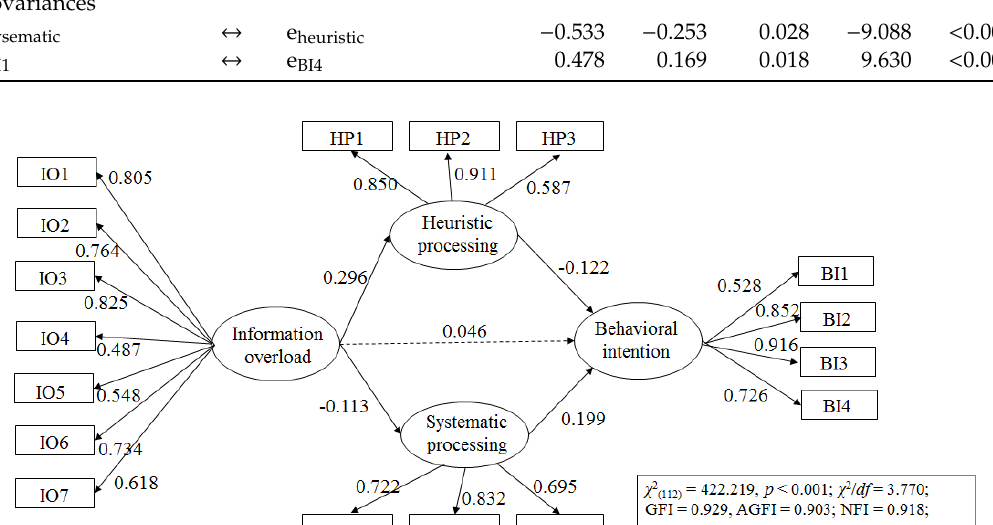
Figure 2. Results of structural equation modeling. Note. IO = information overload; HP = heuristic processing; SP = systematic processing; BI = behavioral intention. The solid lines represent significant relationships, while a dashed line represents a non-significant relationship between variables. Rectangles indicate measured items for variables shown as ovals.